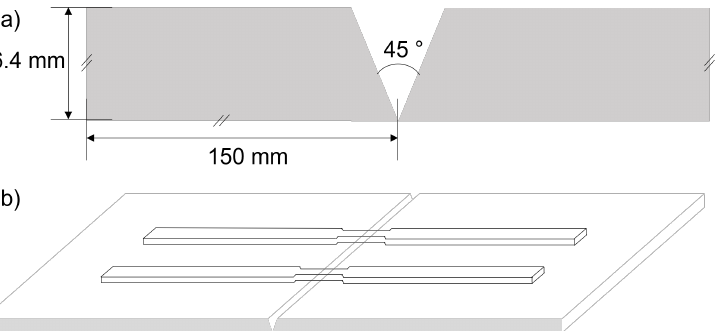
Figure 1. Detail of the V-grooved edges of the sample plates ( a ), and geometry and position of the tensile samples ( b